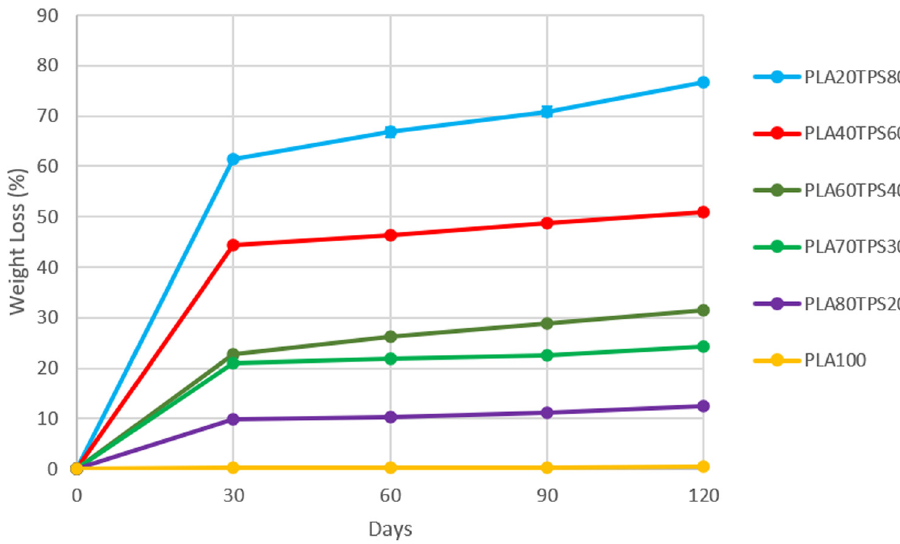
Figure 3: Weight loss against time of PLA100 and PLA/TPS blend